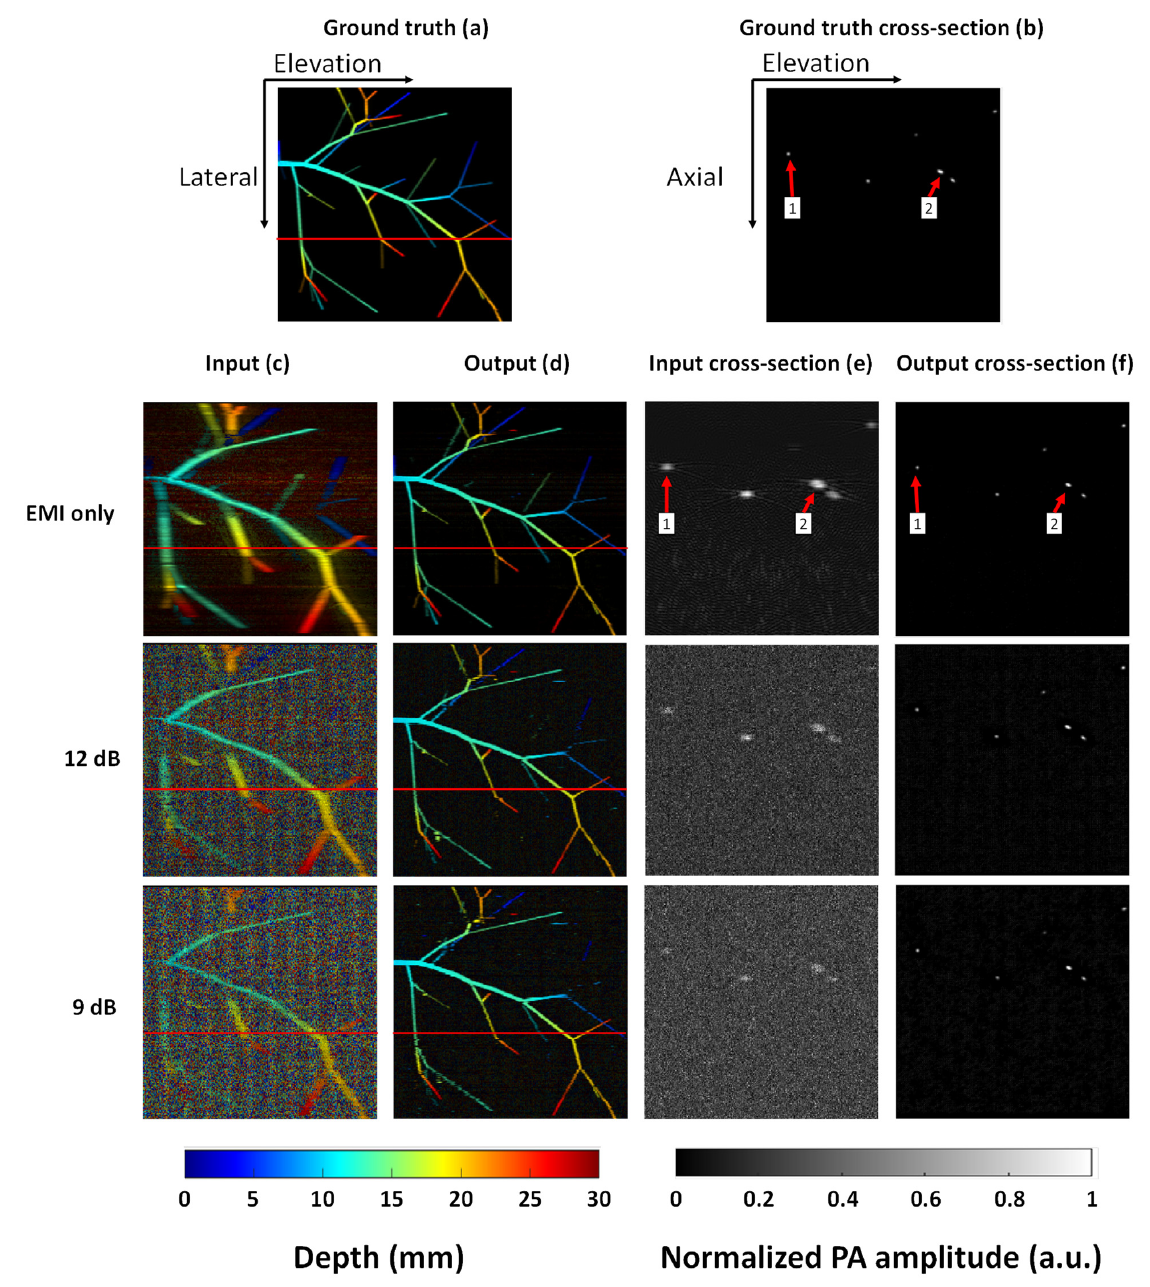
Figure 4. Validation through simulated data. ( a ) Ground truth of generated vasculature. ( b ) Cross-sectional image at the red line marked in ( a ). ( c ) Input images with different noise levels: EMI only, 12 dB Gaussian noise, and 9dB Gaussian noise. ( d ) Output images from the trained network. ( e ) Cross-sectional input images at the red line marked in ( c ). ( f ) Cross-sectional output images at the red line marked in ( d ). Table 1. PSNR and SSIM of input and output in 9dB, 12dB, and EMI